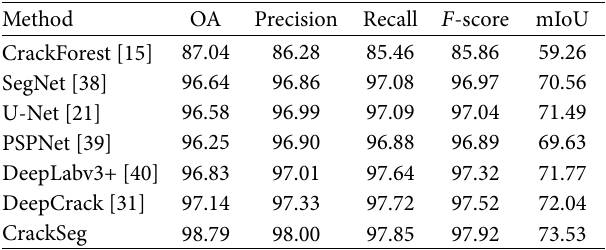
Table 3: Comparisons of the proposed and other methods on the